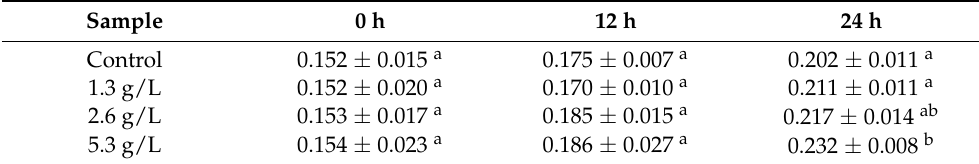
Table 1. Least square means for protease activity (absorbance) of Streptococcus thermophilus STI-06 as influenced by carao over an incubation period of 24 h.